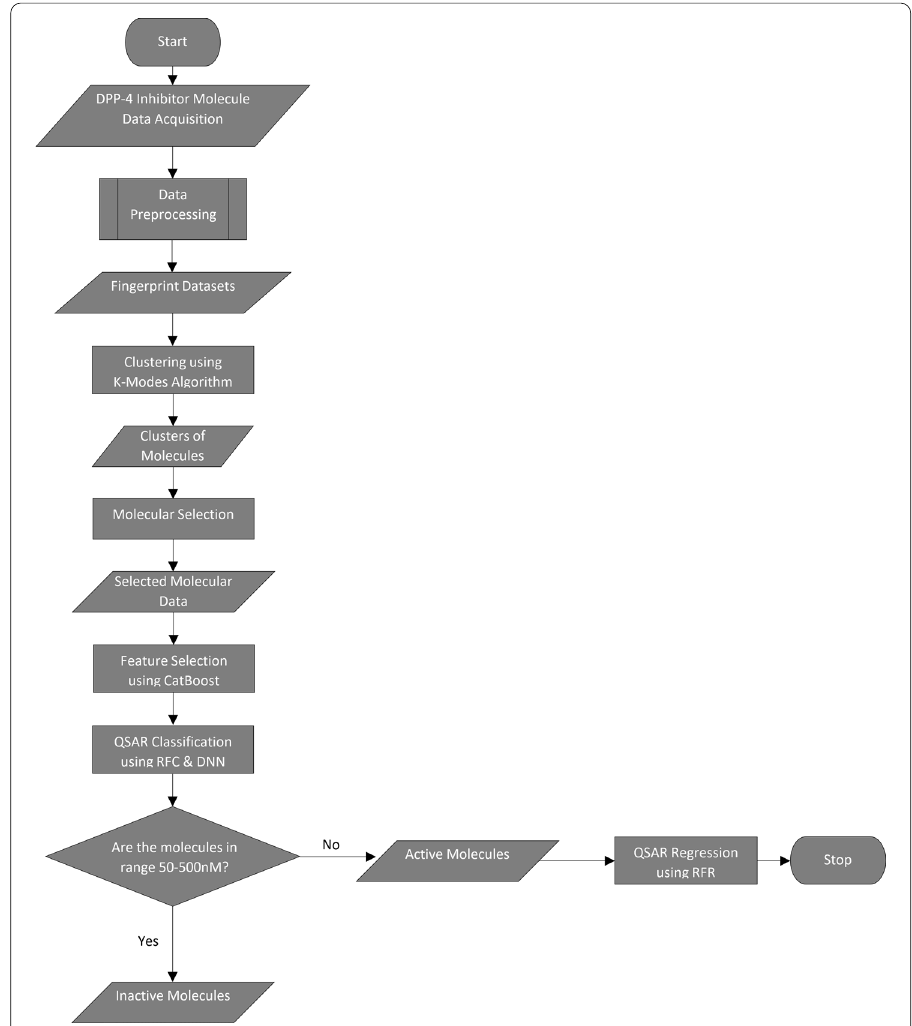
Fig. 1 Schematic representation of purposed